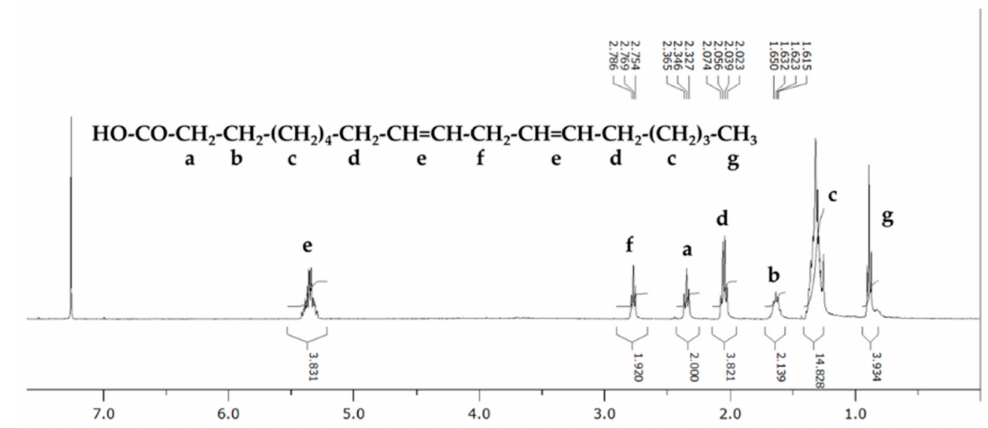
Table 2. The chemical shift values of the unknown peak at 61 min, linoleic acid, linolelaidic acid, 10(E), 12(Z)-conjugated linoleic acid, 9(E), 11(E)-conjugated linoleic acid and 9(Z), 11(Z)-conjugated linoleic acid.